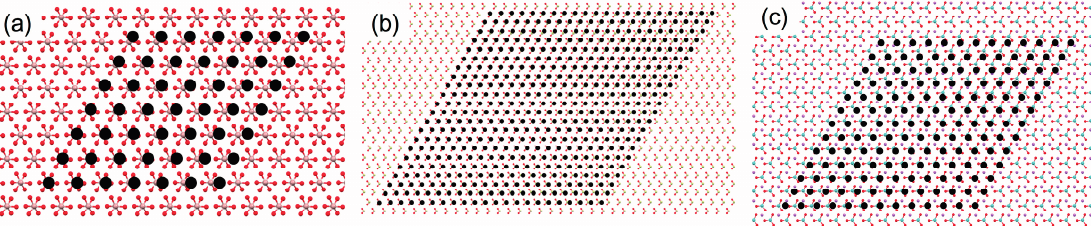
Figure 5. Molecular models to show the maximum supercell dimensions of calcite (0 0 1) that generated the dimensionless potential ( V / V o ) less than 0.5 with the (0 0 1) planes of the substrates: ( a ) Al 2 O 3 ; ( b ) SiO 2 ; and ( c ) LiNbO 3 . The filled black circles are the lattice points of calcite